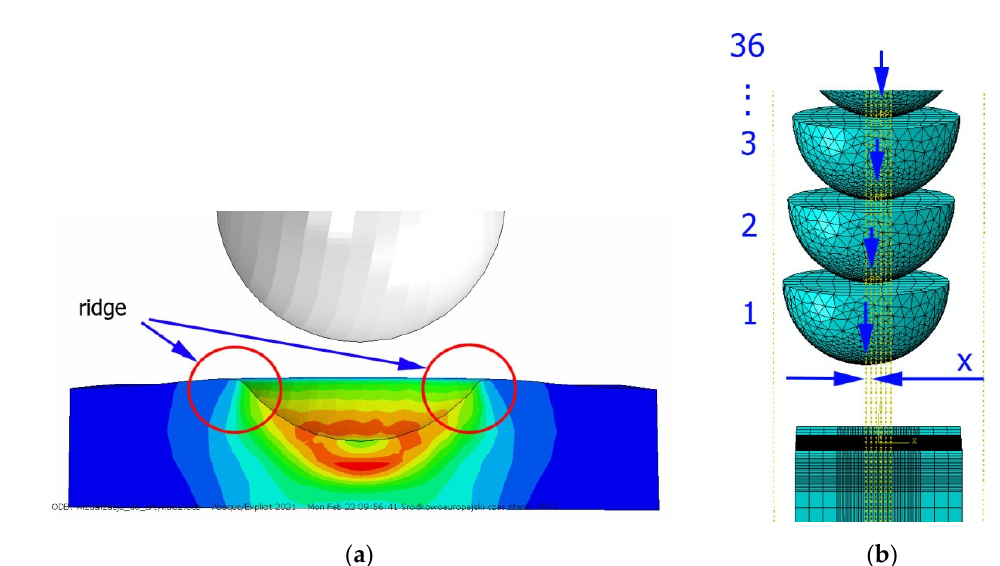
Figure 7. FEM simulation of the shot-peening process: ( a ) view of a single dimple with a ridge, ( b ) visualization of 36 impacts according to the applied methodology.